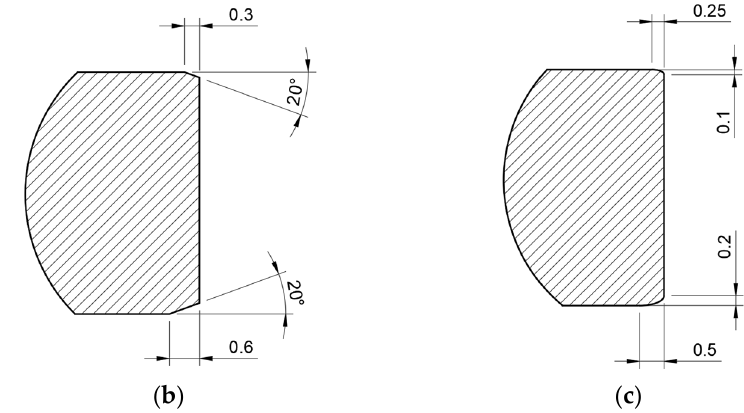
Figure 4. Cutting-edge preparations: ( a ) CBN cutting inserts, ( b ) asymmetrical chamfer, ( c ) elliptical rounding.